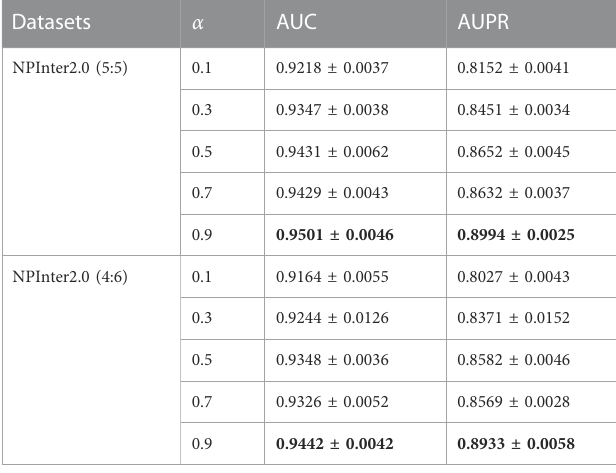
TABLE 5 Performance and standard deviation with fi ve harmonic factor α